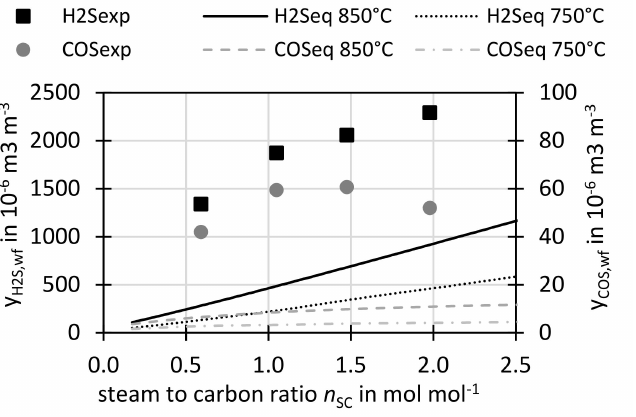
Figure 14. Measured and equilibrium H 2 S and COS concentration on dry and N 2 -free basis at different steam to carbon ratios, additionally equilibrium calculations for ϑ = 750 ◦ C are showing the best possible sulfur